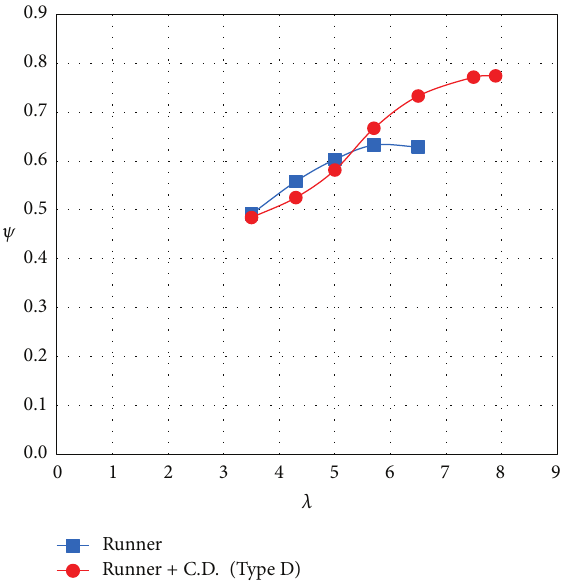
Figure 11: Correlation between the tip speed ratio and the turbine efficiency.